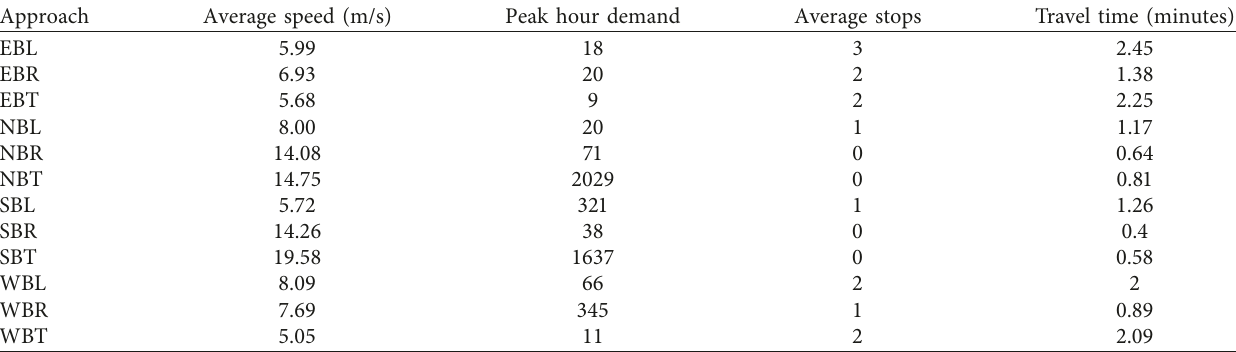
Table 2: Traffic characteristic information on the superstreet at Leeland,